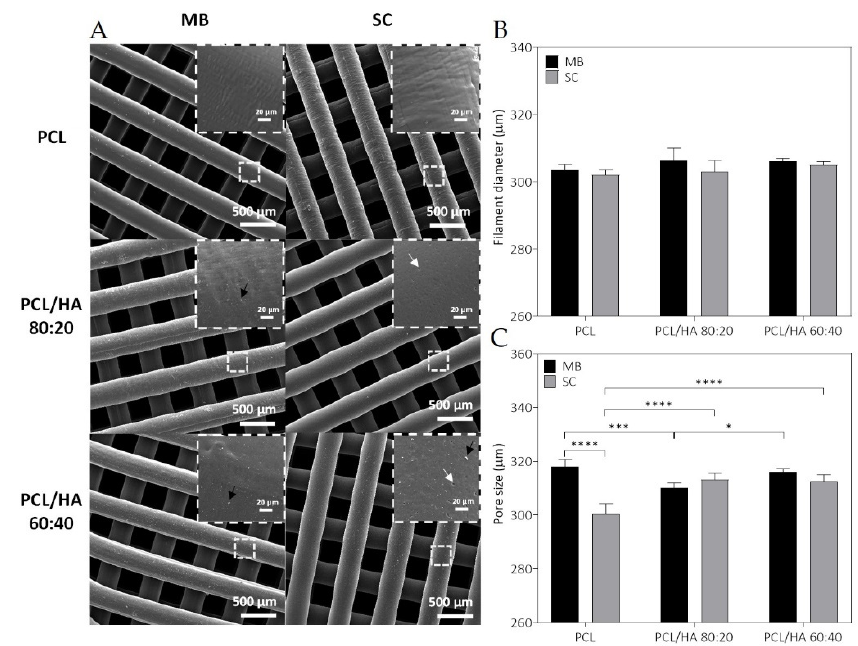
Figure 5. SEM micrographs of PCL and PCL/HA scaffolds, top-view and zoom-in view of the filament (black arrow: HA nanoparticles agglomeration; white arrow: filament micropores) ( A ); the corresponding filament diameter ( B ) and pore size ( C ). The results presented in mean ± SE. Differences were considered statistically significant at p ≤ 0.05. Results’ significance is presented through the symbol (*), according to the p value, with one, three or four symbols, corresponding to 0.01 < p ≤ 0.05; 0.0001 < p ≤ 0.001 and p ≤ 0.0001, respectively.